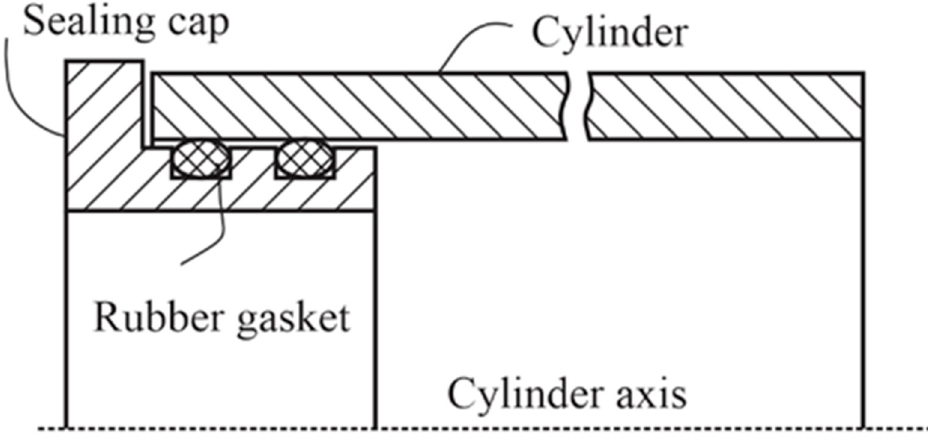
Figure 2. The schematics of the underwater ROV command-and-control cylinder sealing system.